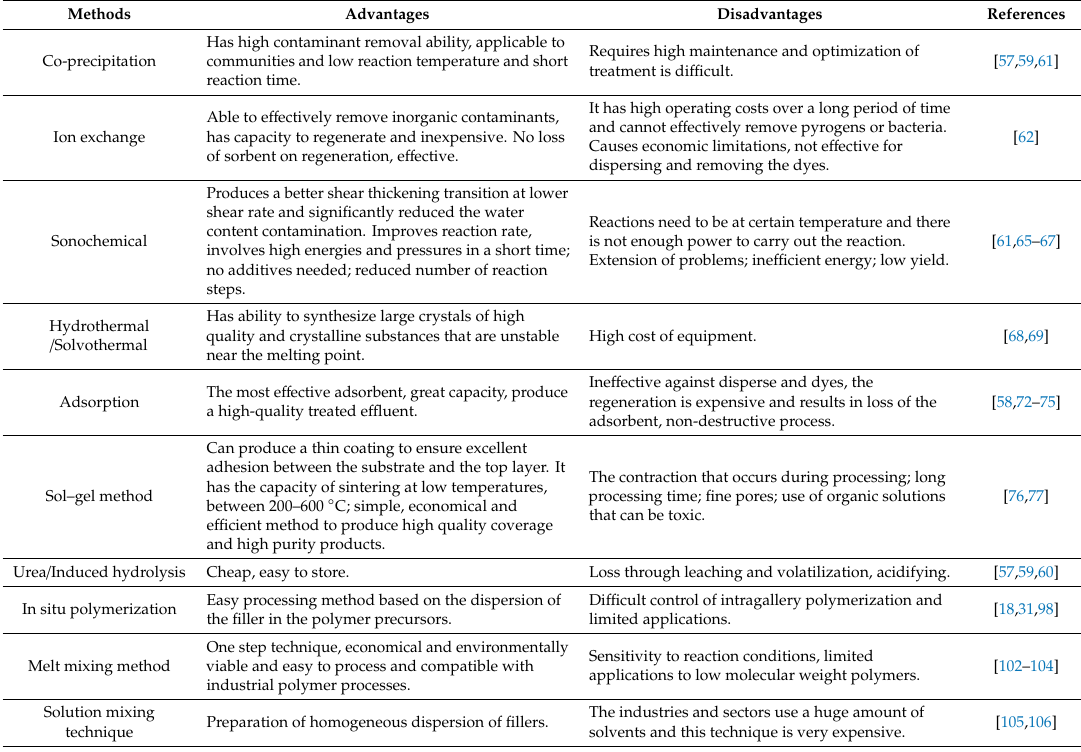
Table 5. Advantages and disadvantages of di ff erent methods of LDHs and clays in water